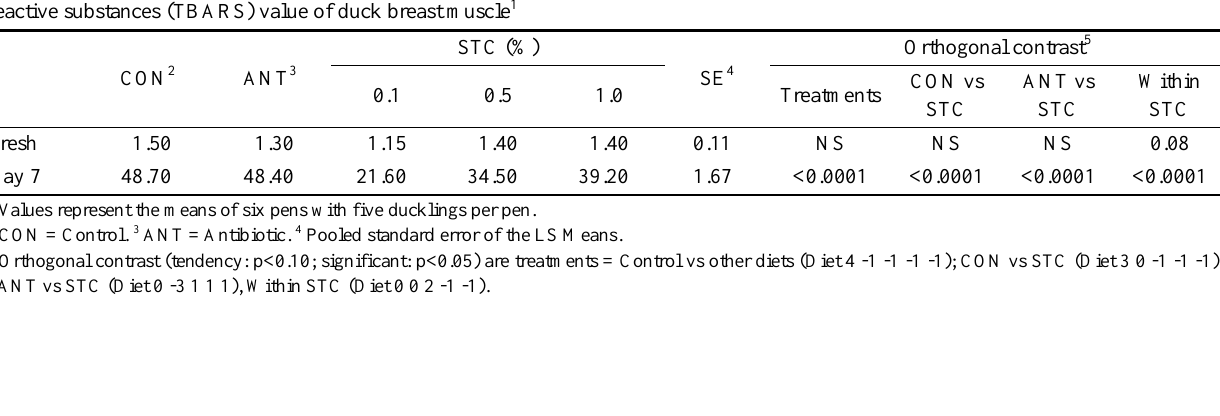
1 Values represent the means of six pens with five ducklings per pen. 2 CON = Control. 3 ANT = Antibiotic. 4 Pooled standard error of the LS Means. 5 Orthogonal contrast (tendency: p<0.10; significant: p<0.05) are treatments = Control vs other diets (Diet 4 -1 -1 -1 -1); CON vs STC (Diet 3 0 -1 -1 -1);